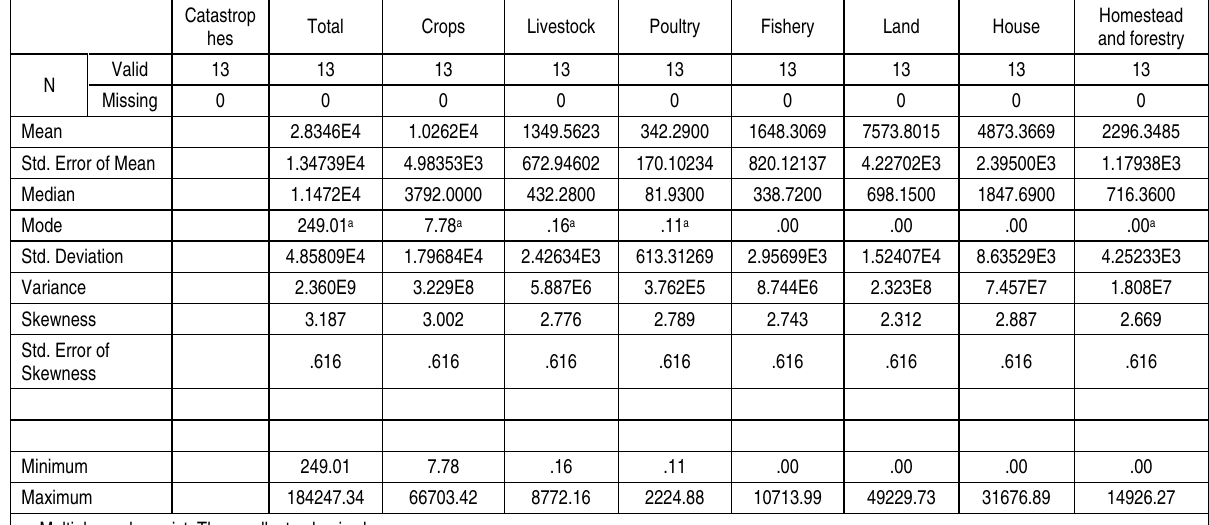
Table 4. Statistics (secondary sources)